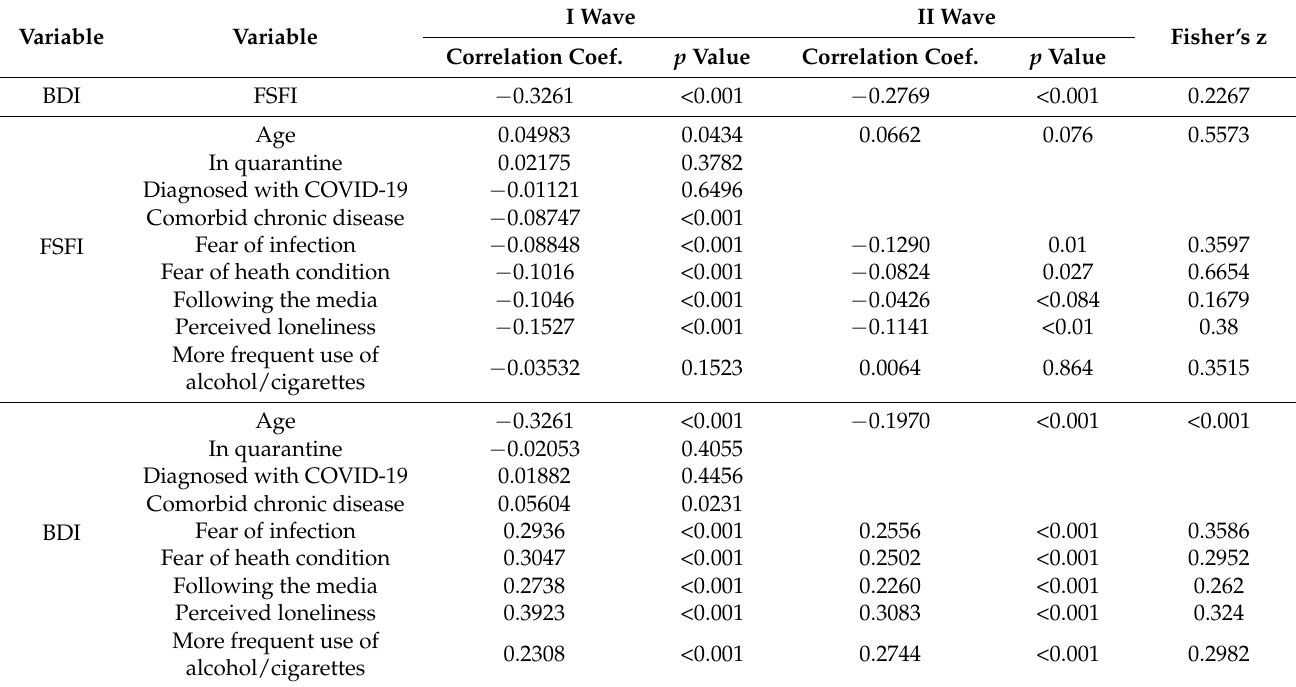
Table A4. Correlations between BDI, FSFI and COVID-19-related